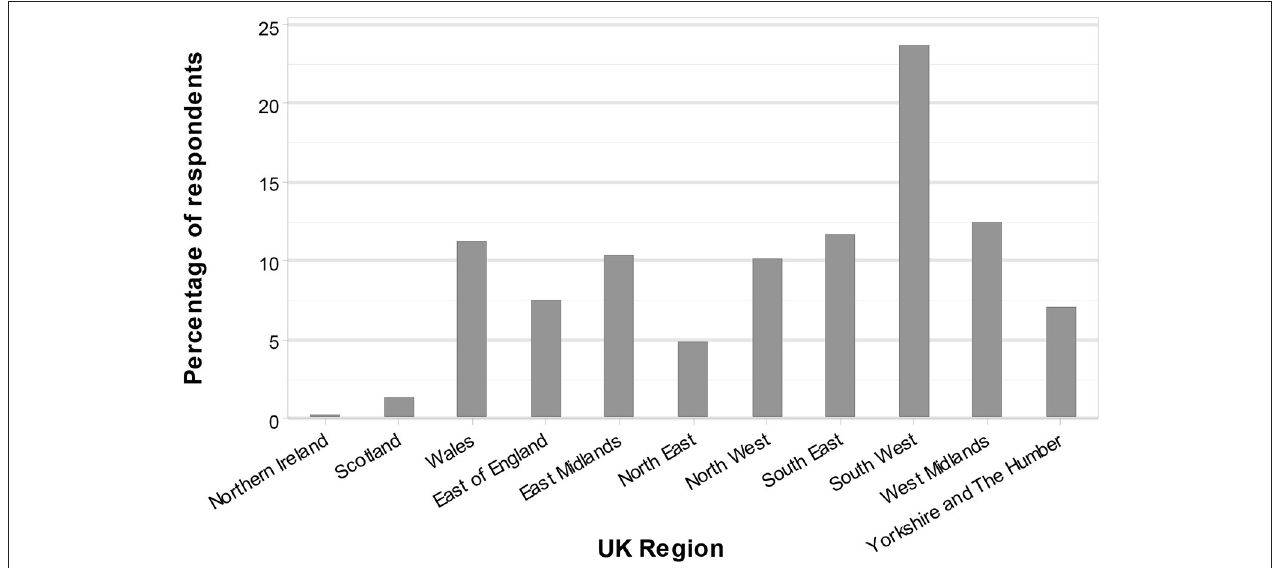
FIGURE 1 | Farm location of respondents, by region, as a percentage of respondents (Q29, n = 483). Regions utilized are Northern Ireland, Scotland, Wales, and the nine official regions of England. There were no respondents from Greater London.